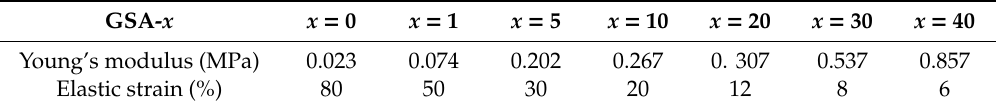
Table 3. GSA elastic strain and Young’s